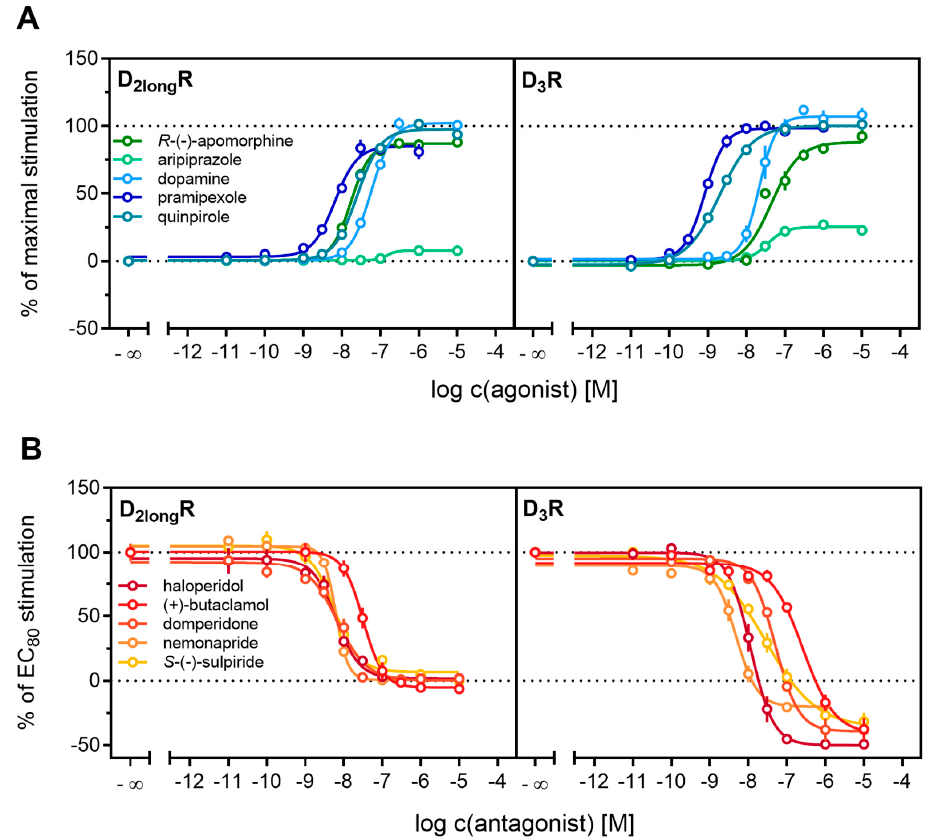
Figure 4. Characterization of standard ligands in the β -arrestin2 recruitment assay. A set of agonists ( A ) and antagonists ( B ) were tested for their ability to promote or inhibit (the quinpirole-induced) β -arrestin recruitment at the D 2long R and the D 3 R. Data of agonists were normalized to the maximal stimulation induced by 1 µM quinpirole (100%) and a solvent control (0%). Antagonist data were normalized to the signal elicited by quinpirole at a concentration corresponding to the EC 80 (100%) and a solvent control (0%). Obtained pEC 50 , E max and pK b values are presented in Table 2. Data represent means ± SEM from at least three independent experiments, each performed in